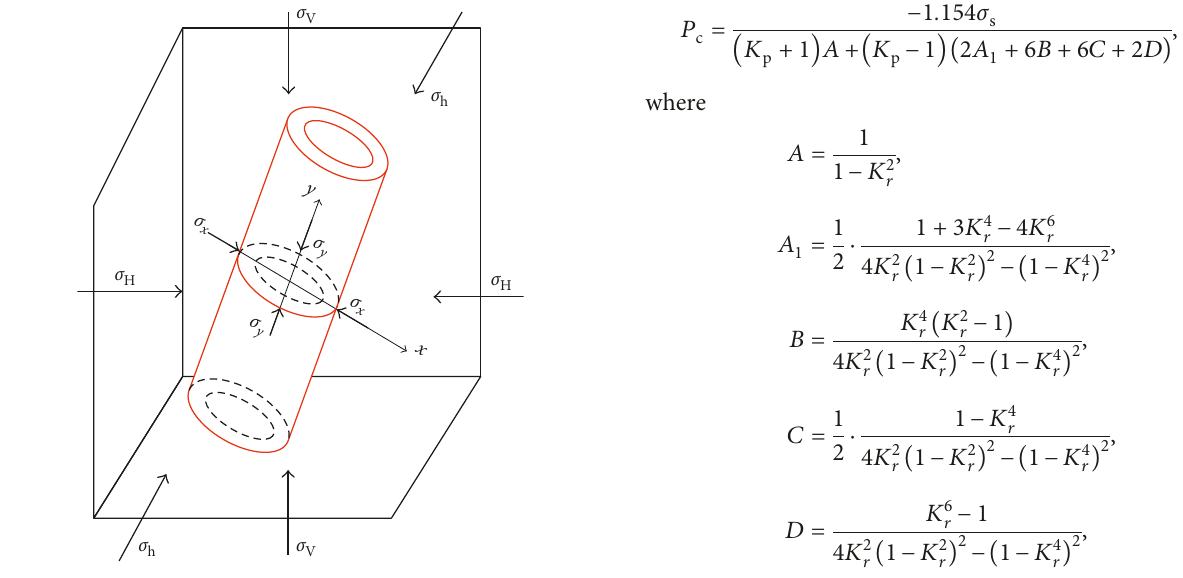
Figure 3: Sketch for mechanical model of casing under com- pression in